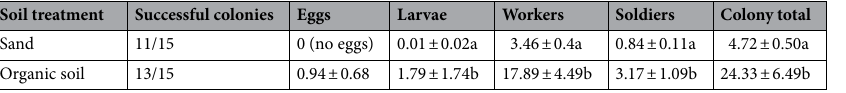
Table 2. Total termite colony nitrogen (mg) present in all castes of 20 month-old C. formosanus colonies after being reared for 6 months on either sand or organic soil (mean ±